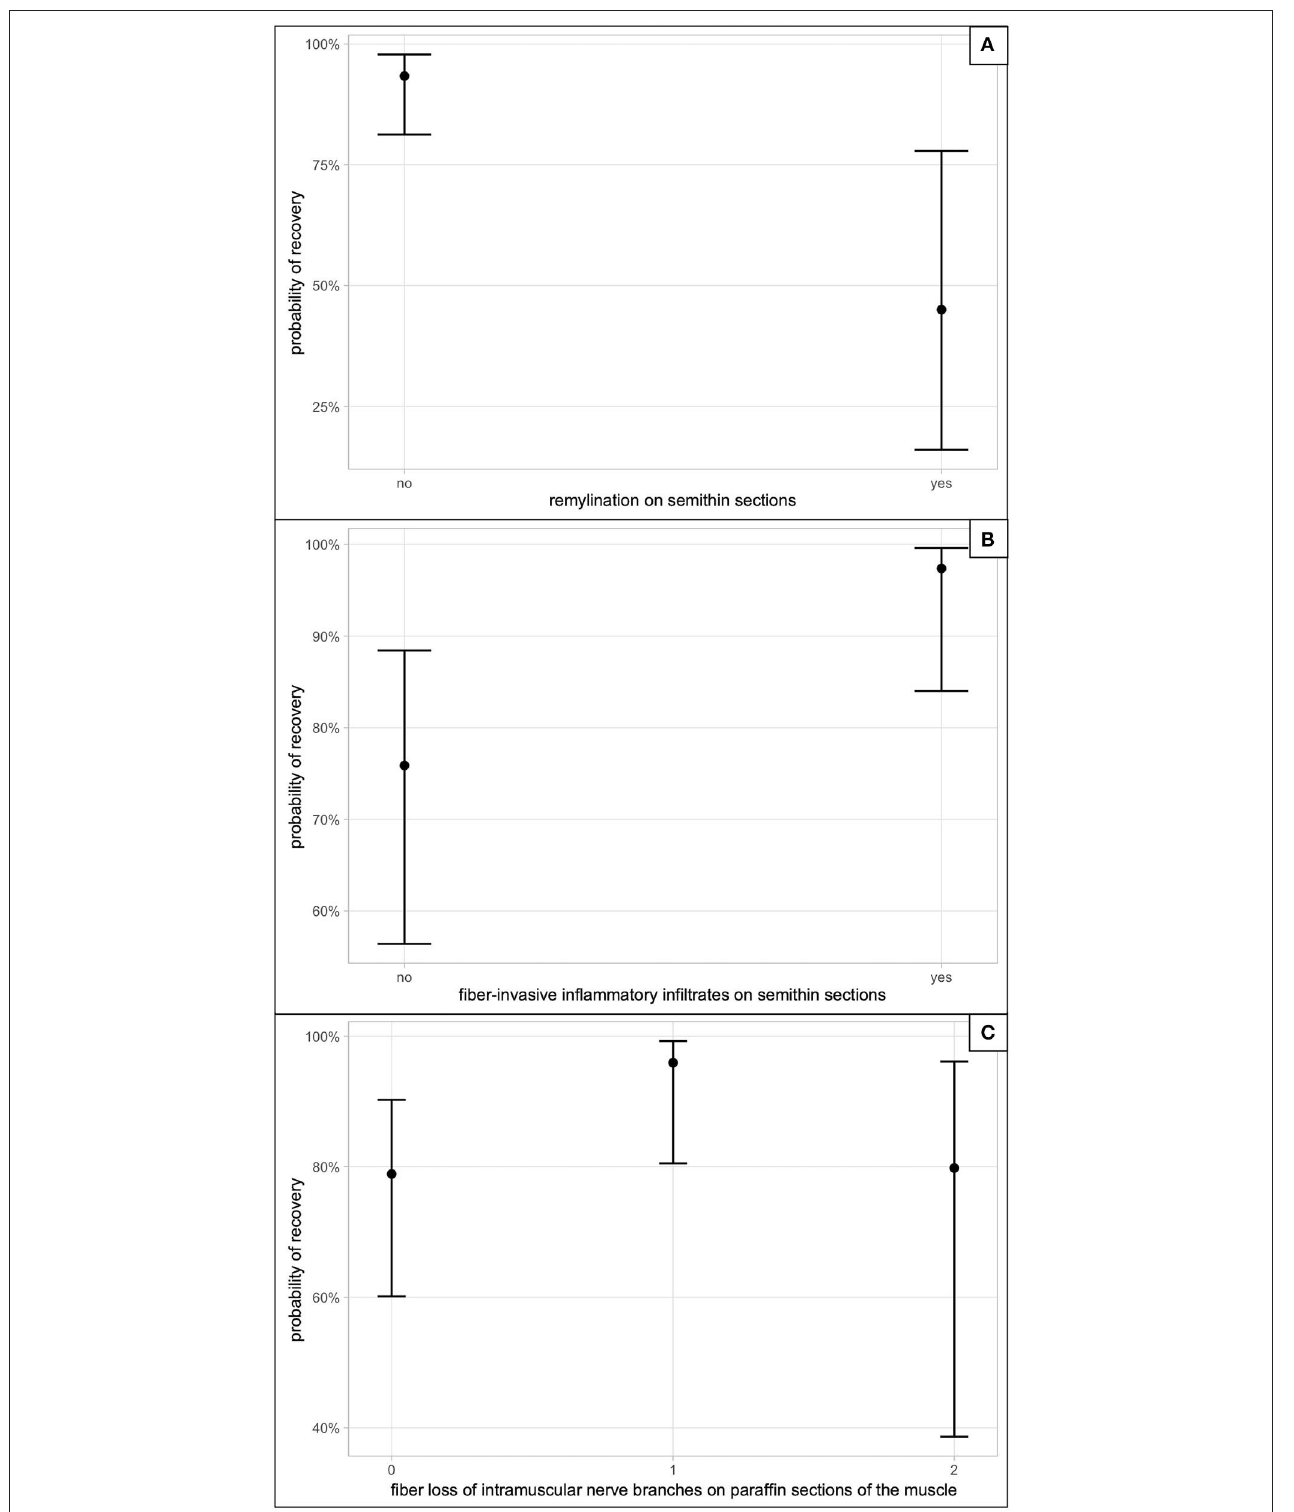
FIGURE 3 | Probability of recovery in the multivariate model. (A) The impact on recovery, if remyelination on semithin sections was observed. (B) The correlation between presence of fiber-invasive inflammatory infiltrates on semithin sections and recovery. (C) Correlates the semiquantitative fiber loss score of intramuscular nerve branches seen on paraffin sections of the muscle in degree; 0, absent; 1, mild; 2, moderate; 3, severe ( n = 0).